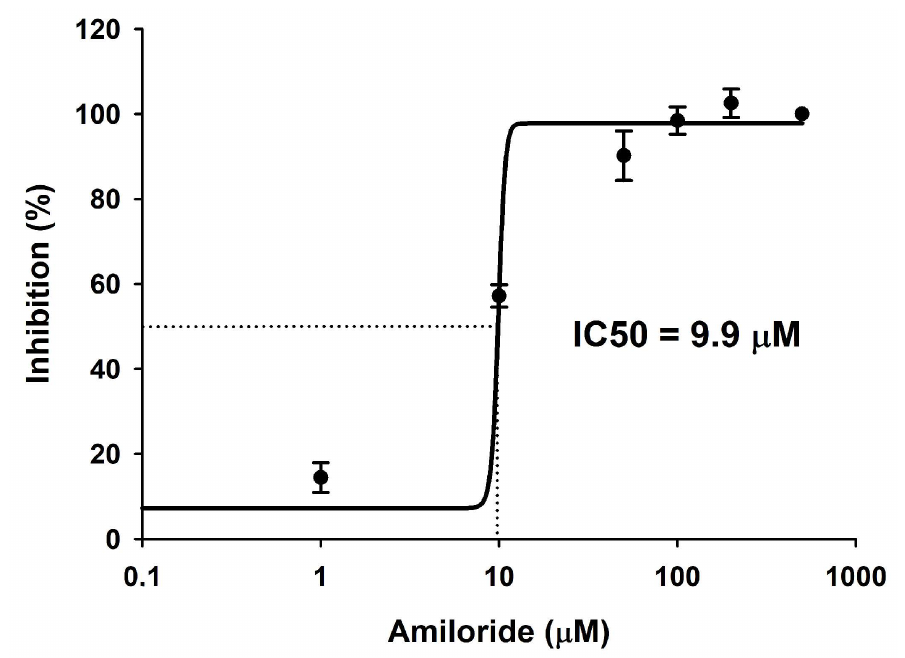
Figure 4. Biochemical inhibition of an ouabain/bafilomycin A1-insensitive ATPase enzyme in gills of S. canicula by amiloride. Dose-dependent inhibition of this ATPase activity by amiloride, and half- maximal inhibitory concentration (IC50), calculated with the best-fit equation was 9.9 µ mol L − 1 . The data-points show mean ± s.e.m. from five independent assays in each of which amiloride-sensitive ATPase activity was measured in